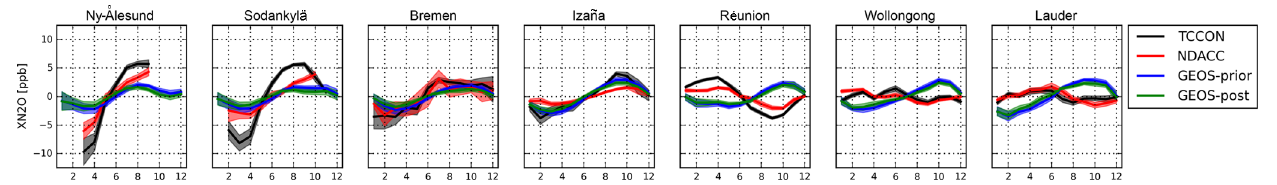
Figure 9. The X N seasonal variations from TCCON and NDACC FTIR measurements (all available data during 2007–2017; see Fig. 3) 2 O and a priori and a posteriori model simulations (2007–2014) together with their uncertainties at each